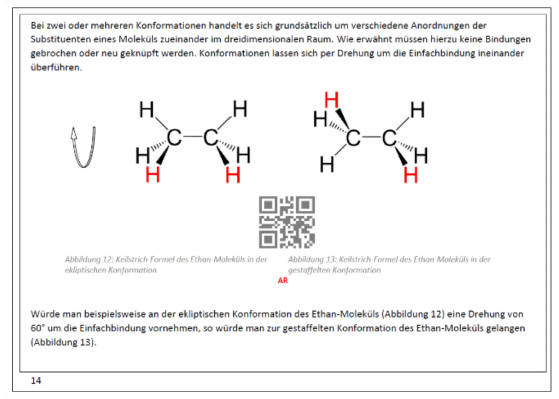
Figure 2. Example of the learning material about stereochemistry.